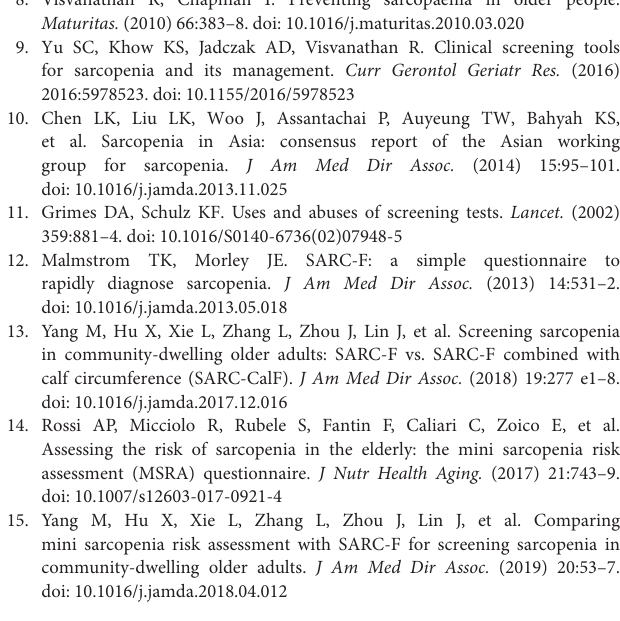
Supplementary Figure 1 | The flowchart Bushehr Elderly Health (BEH) Program, phase I. Supplementary Figure 2 | The distributions and histograms of variables of SarSA-Mod in both genders. Supplementary Table 1 | The area under curve and other characteristics of calf circumference as screening tool for sarcopenia in the whole study